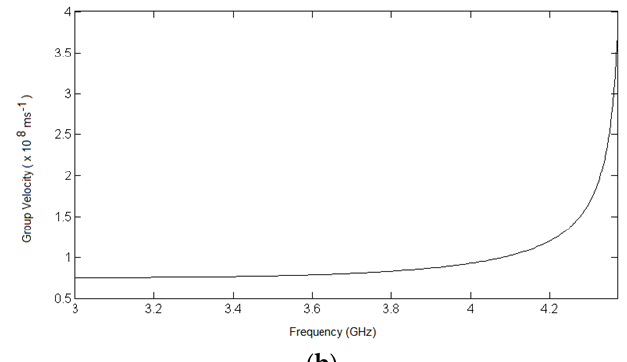
Figure 2. Details of the experiment. ( a ) The photo showing the actual measurement setup for measuring the blood glucose on the left hand; and ( b ) calculated group velocity of a surface wave propagating in the curved Goubau line (of which the diameter of the central conductor is 1 mm and the thickness of the gelatin coating is 3.8 mm).